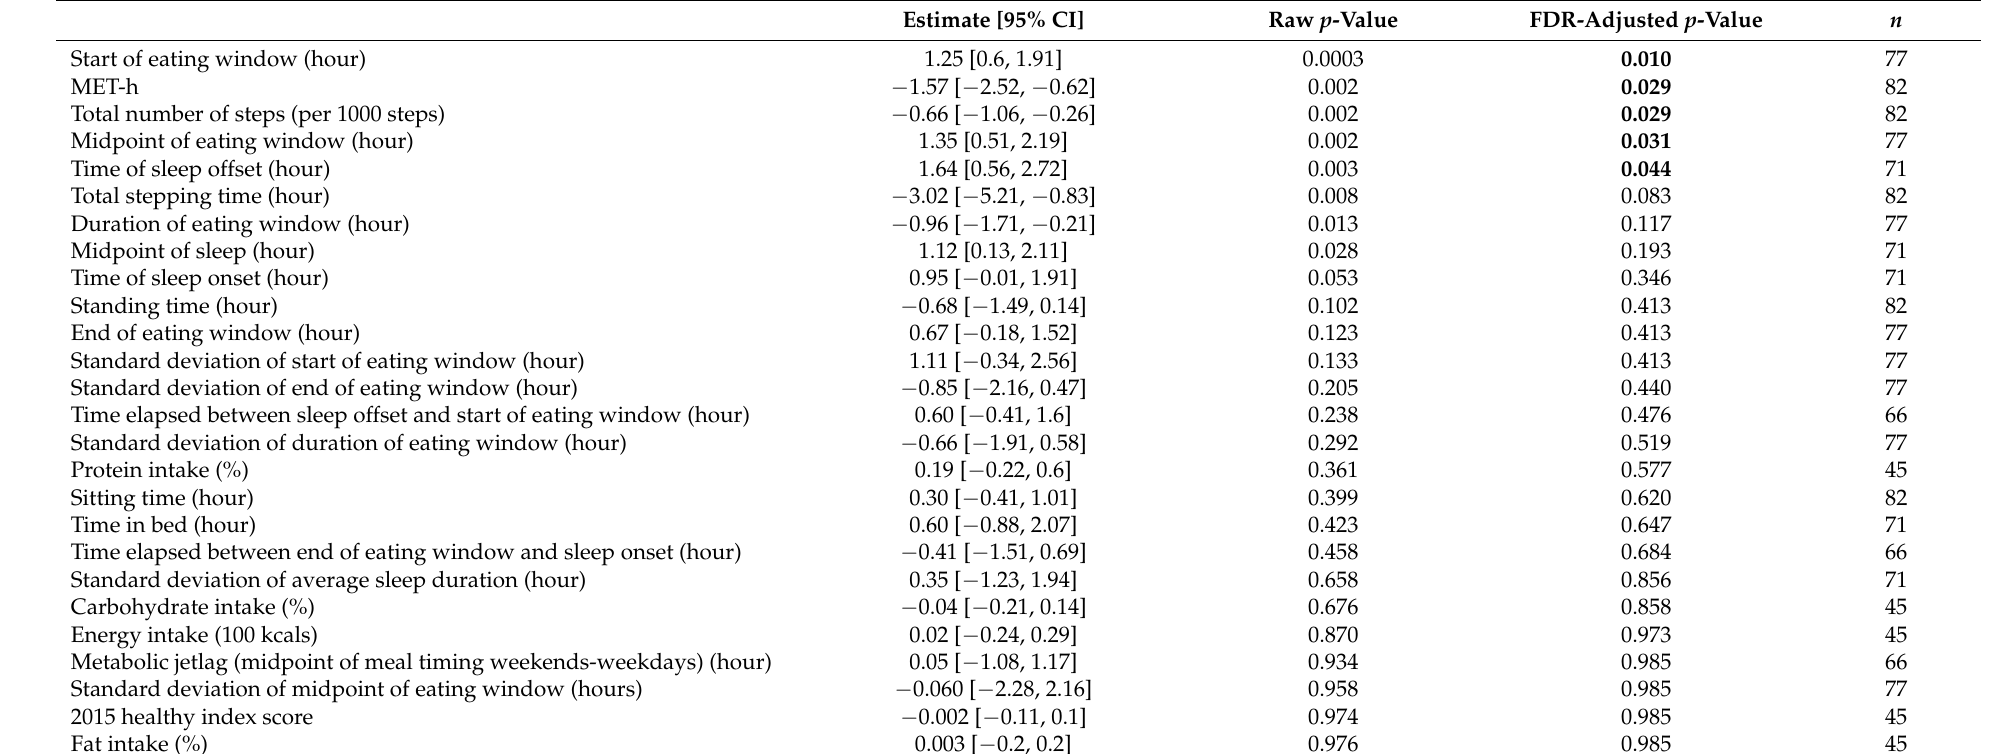
Table 3. Linear regressions with percent body